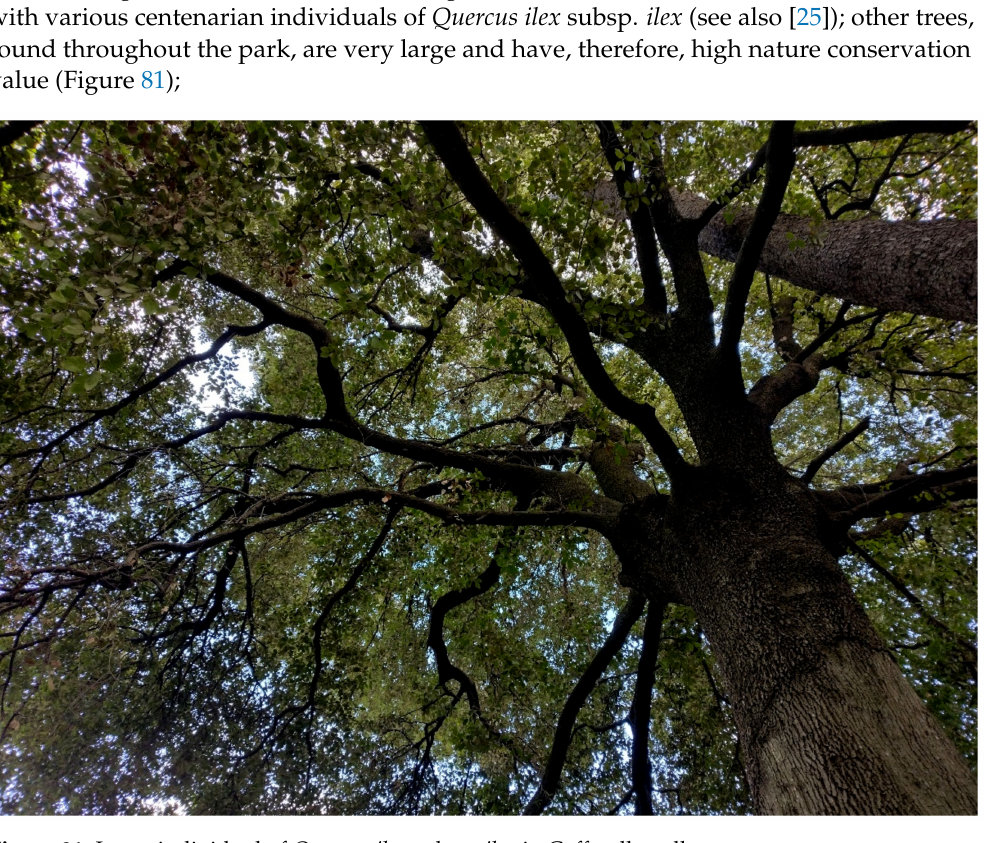
Figure 81. Large individual of Quercus ilex subsp. ilex in Caffarella